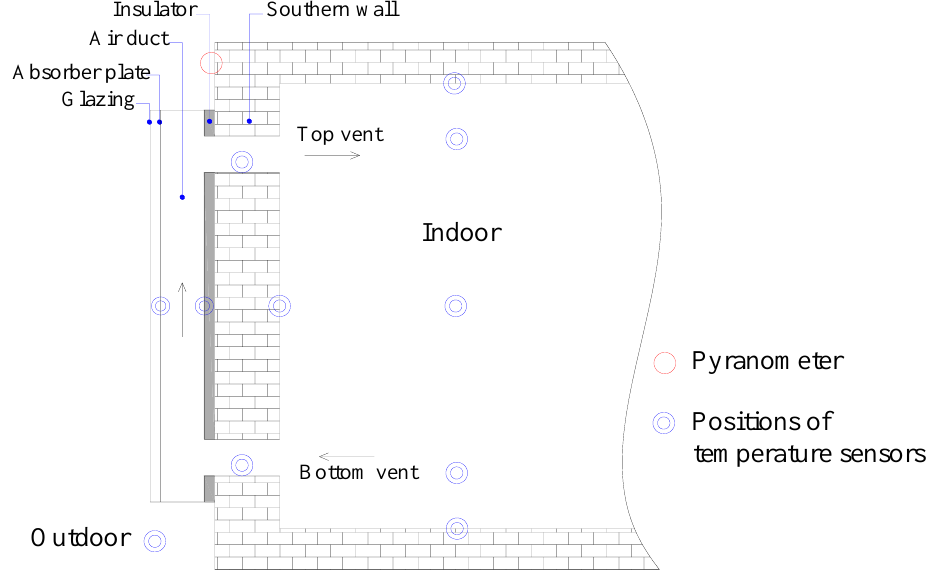
Figure 3. The schematic of test room with DFSC.